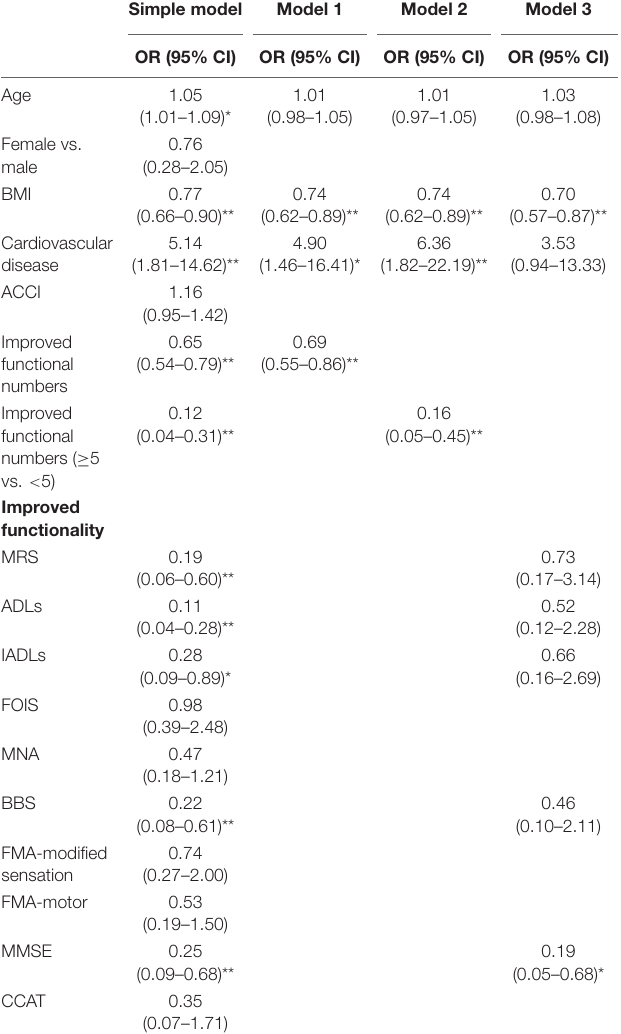
TABLE 3 | Predictors of 1-year mortality or 14-day readmission outcome in patients with PAC. Simple